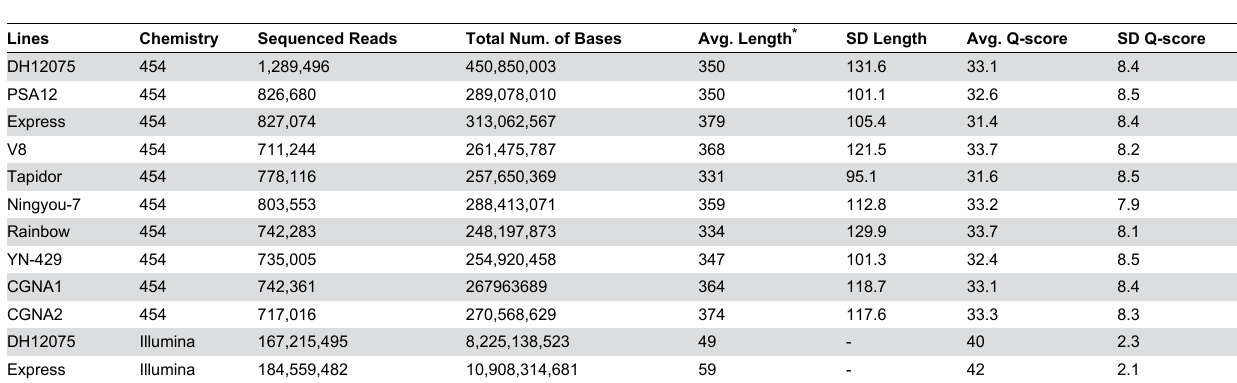
Table 1. Summary of Next Generation Sequencing (NGS)